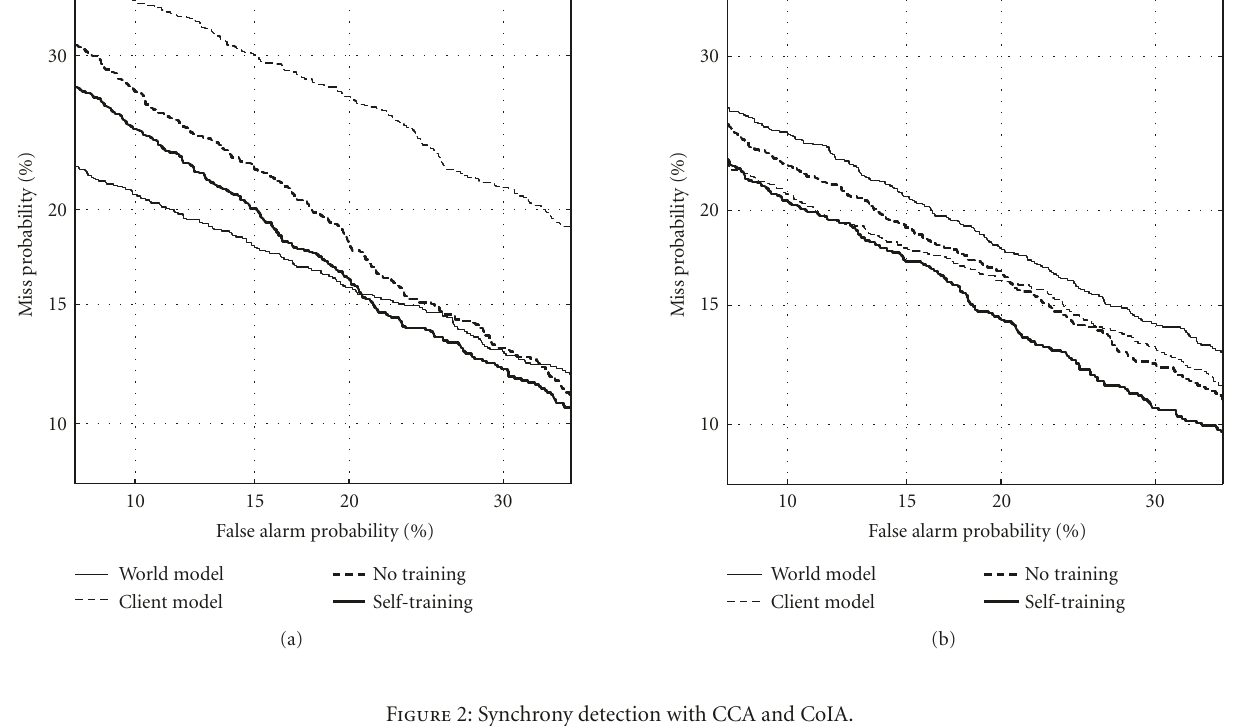
Figure 2: Synchrony detection with CCA and CoIA.